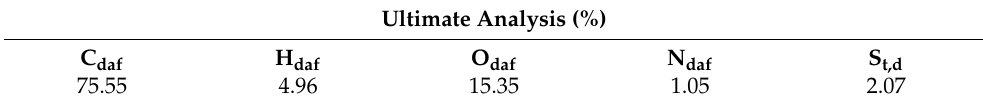
Table 1. Ultimate analysis of coal